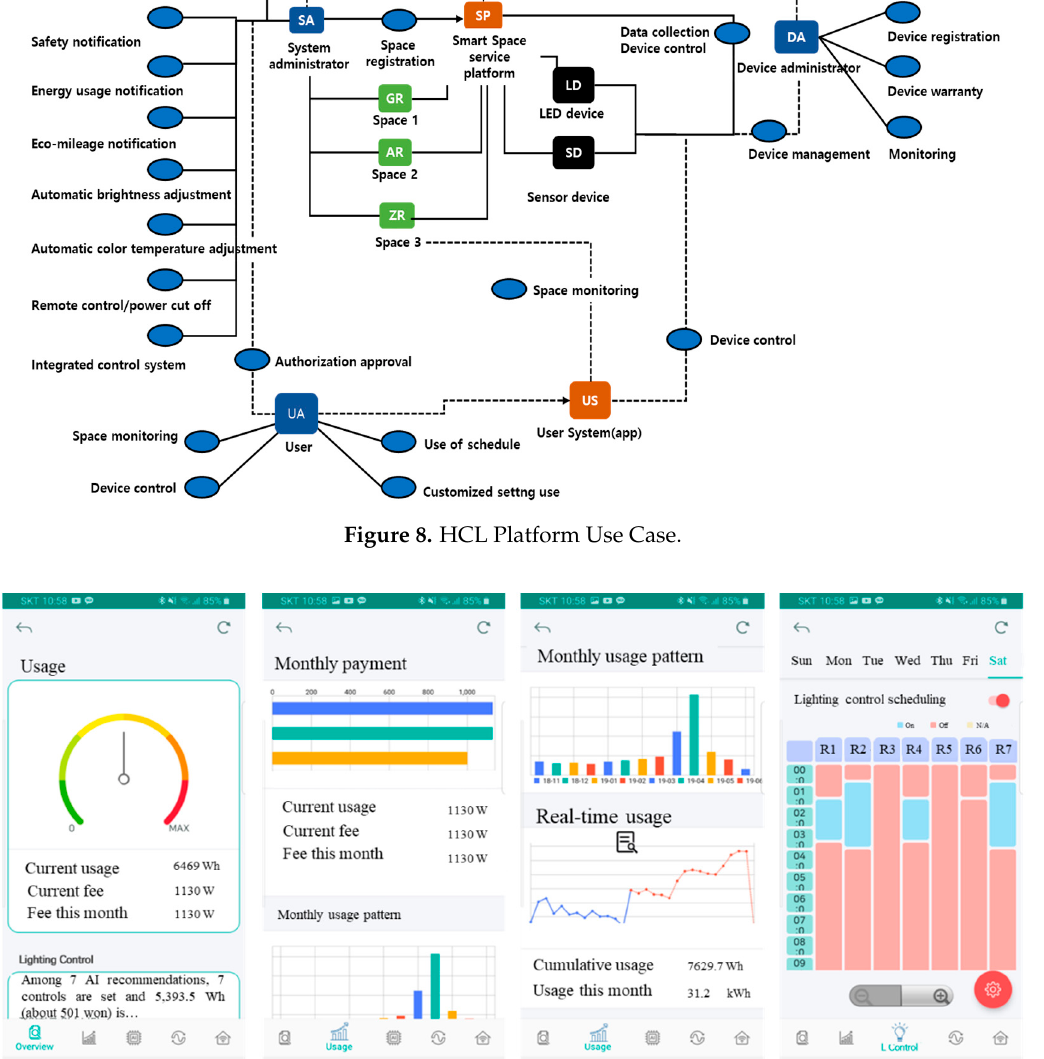
Figure 9. HCL Application UI.